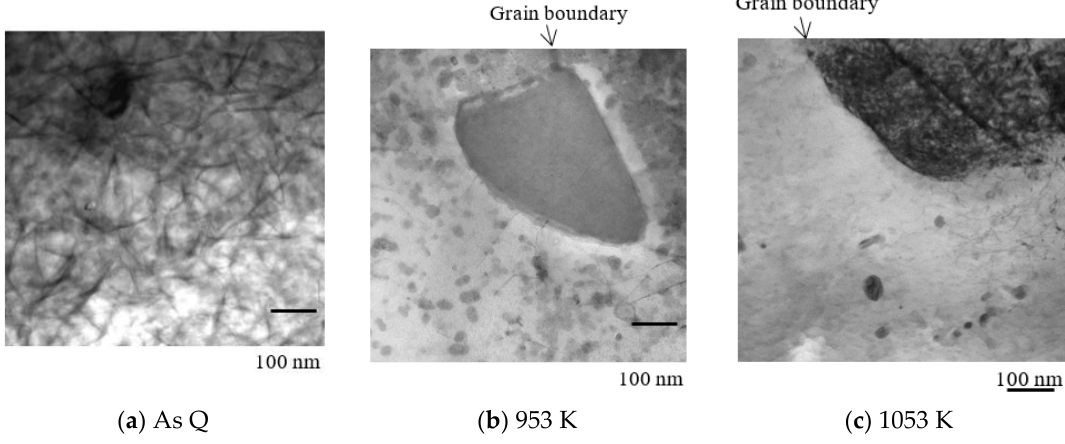
Figure 9. TEM images of as-Q sample ( a ) and as-L sample heated to 953 K ( b ) and 1053 K ( c ).